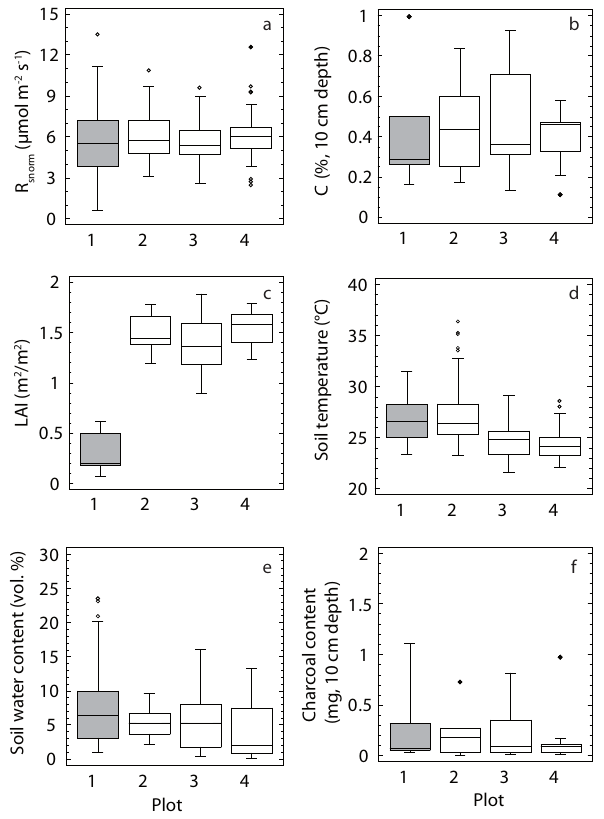
Fig. 7. Plot specific values for normalized soil respiration (a) and several biotic ( b and c ) and abiotic parameters ( d, e and f ) are shown to visualize between plot differences – 2009 only. Average values of the various variables in Plot 1 (disturbed) did not deviate sig- nificantly from values derived for the three other plots (2–4, undis- turbed). The only exception was shown for values of leaf area index. Filled dots represent